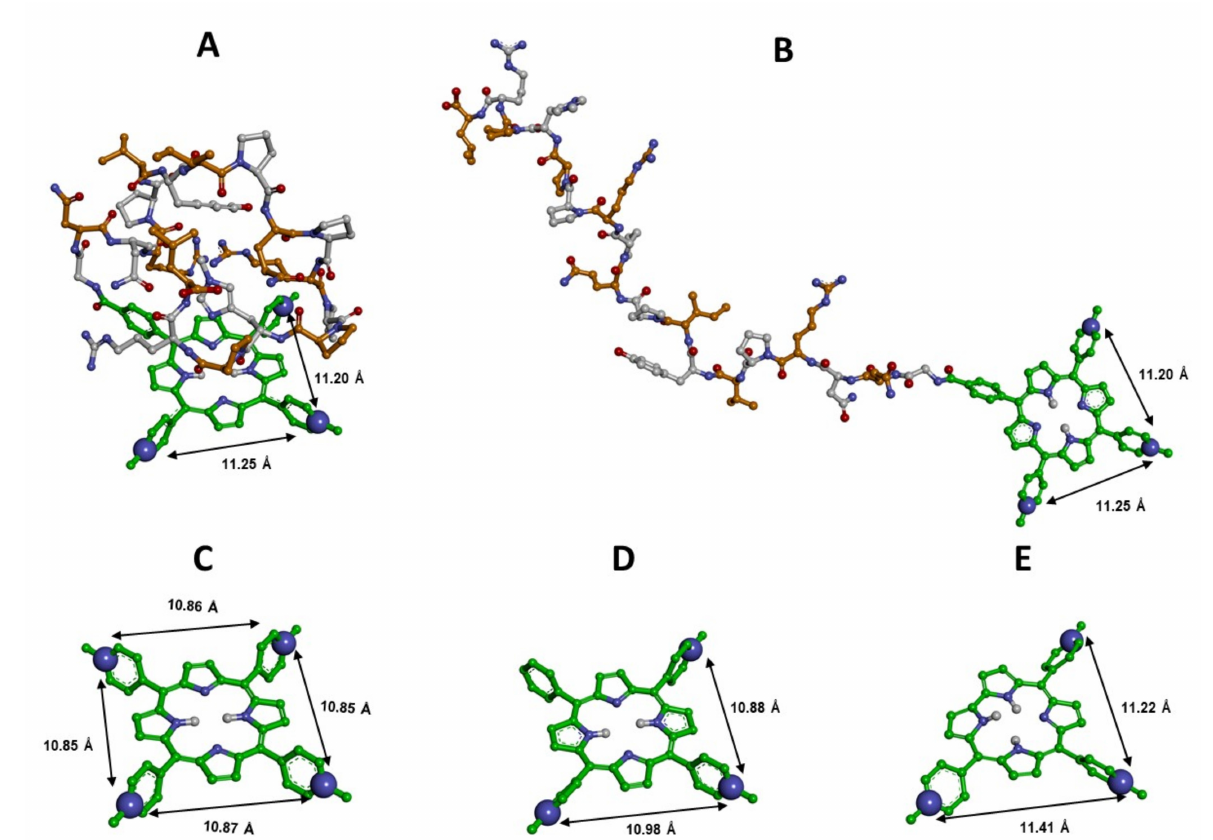
Figure 2. Comparison of the calculated structures of MTPyApi ( A , B ) and TMPC ( E ) with those of the reference compounds H 2 T4 ( C ) and Tris-T4 ( D ). The inter-atomic distances between adjacent protonated nitrogen atoms are reported. Molecules are displayed in ball-and-stick with the pyridine nitrogen atoms evidenced in CPK (scaled by 50%). The porphyrin ring carbon atoms are colored in green. Carbon atoms of the apidaecin residues are colored in white and orange alternately. For sake of clarity, only the hydrogen atoms of the pyrrole nitrogen are